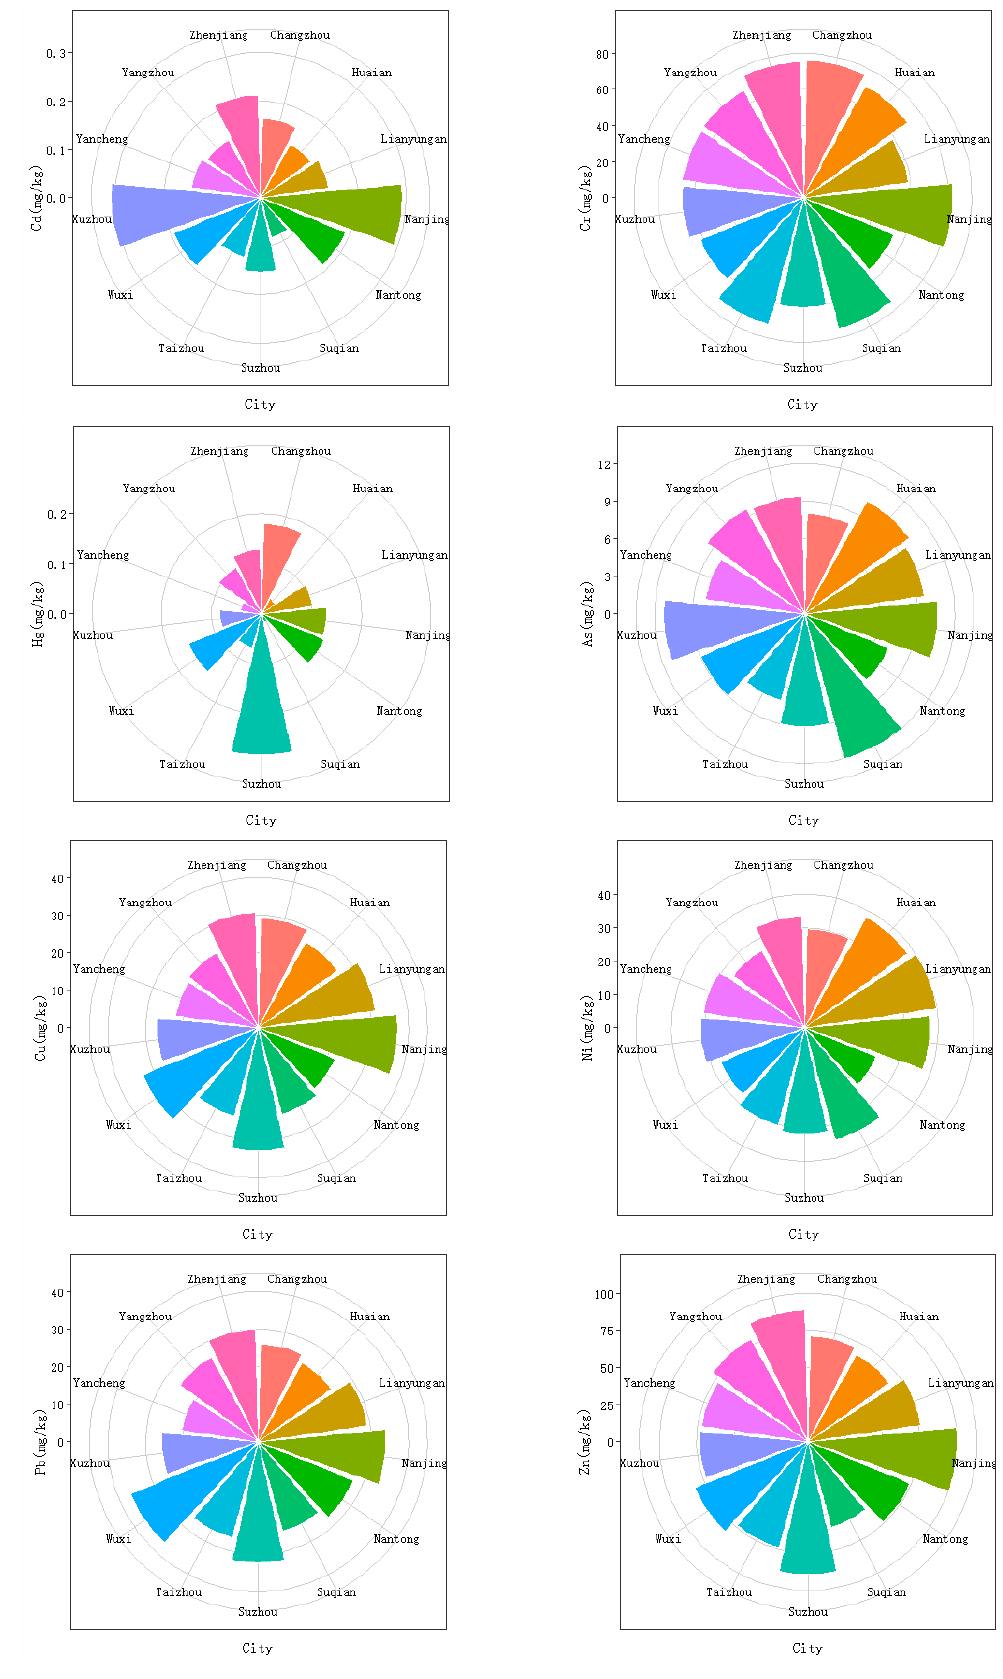
Figure 2. The weighted mean values of heavy metals in di ff erent cities.